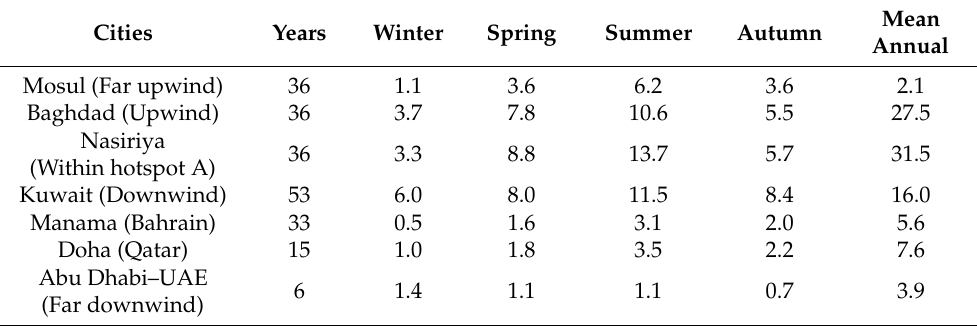
Table 1. The SDS days average number in the study area for up- and downwind cases with respect to the sources. Cities